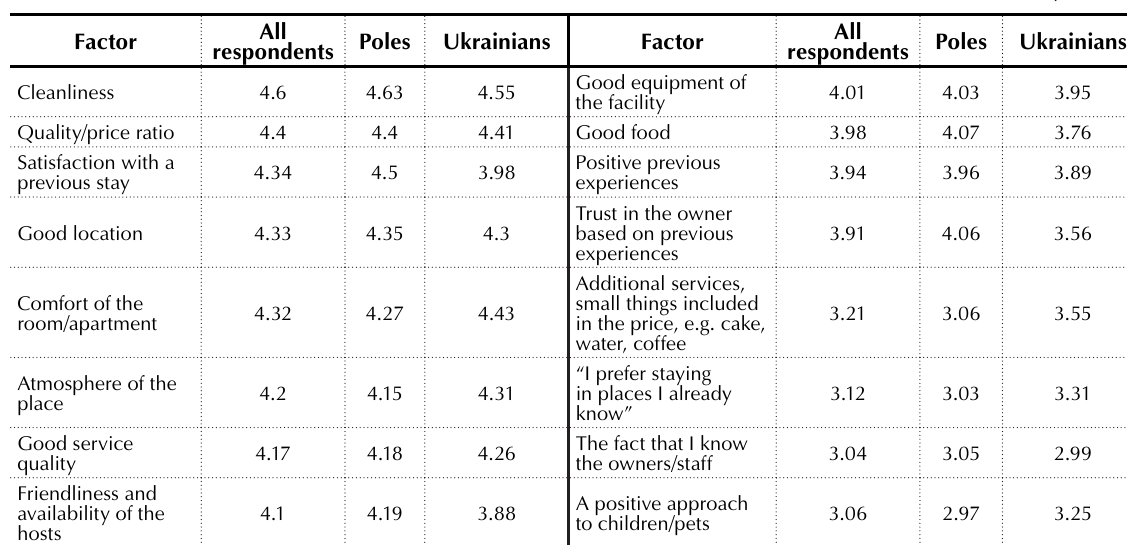
Table 5. Determinants of a possibility of returning to a given accommodation facility